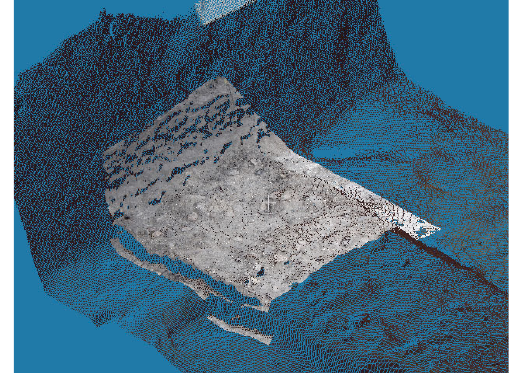
Figure 10. Placing 3D data